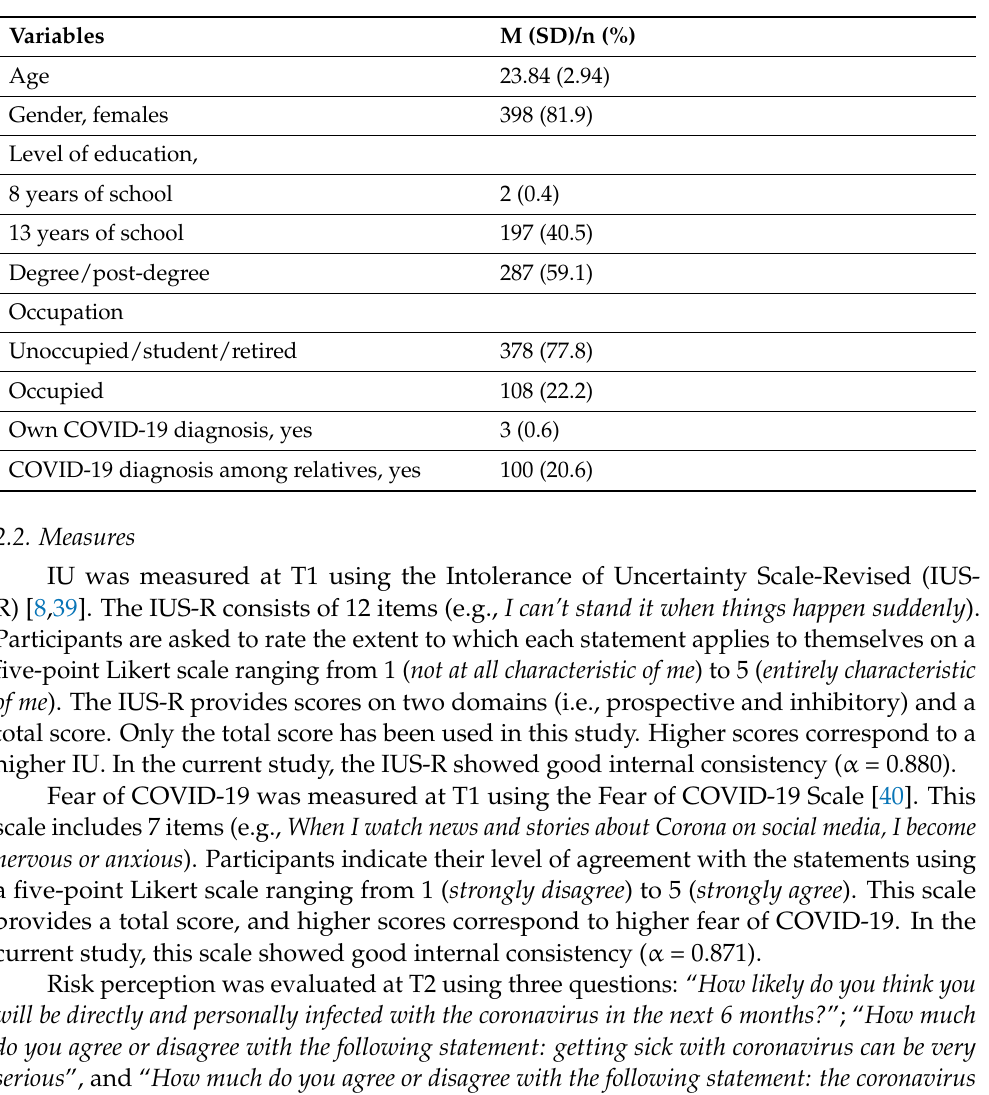
Table 1. Participants’ demographic and health-related data ( n =